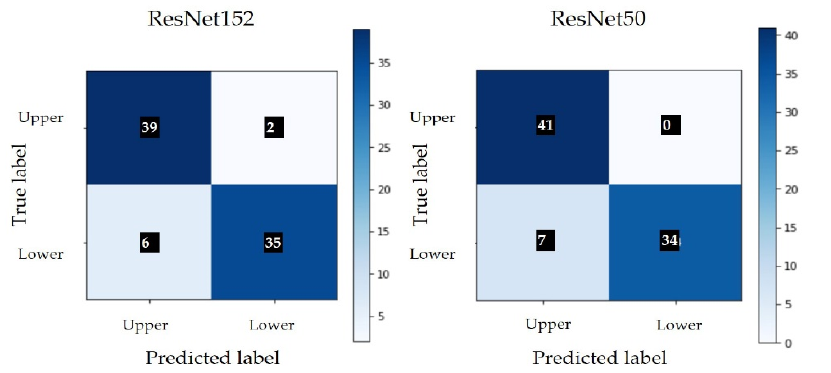
Figure 6. Confusion matrix without normalization.